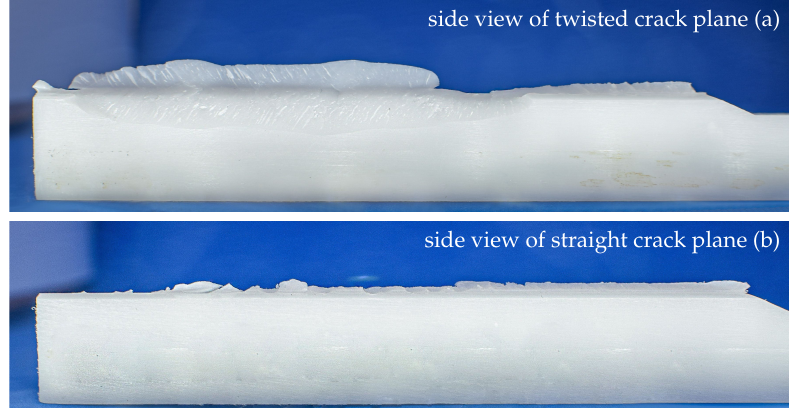
Figure 15. Fracture surface images from monotonically loaded mode III specimens (side view)—two different types of surface structure were observed: twisted crack planes along the fracture surface ( a ) and a nearly straight crack plane with little deflections ( b